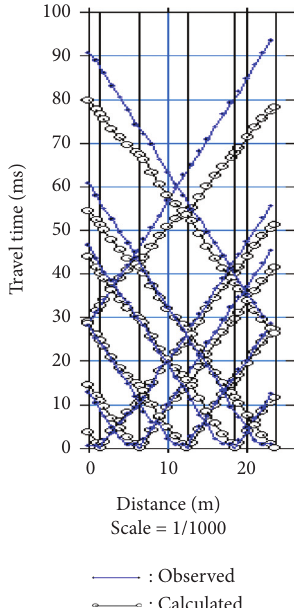
Figure 10: Example of calculated and observed travel